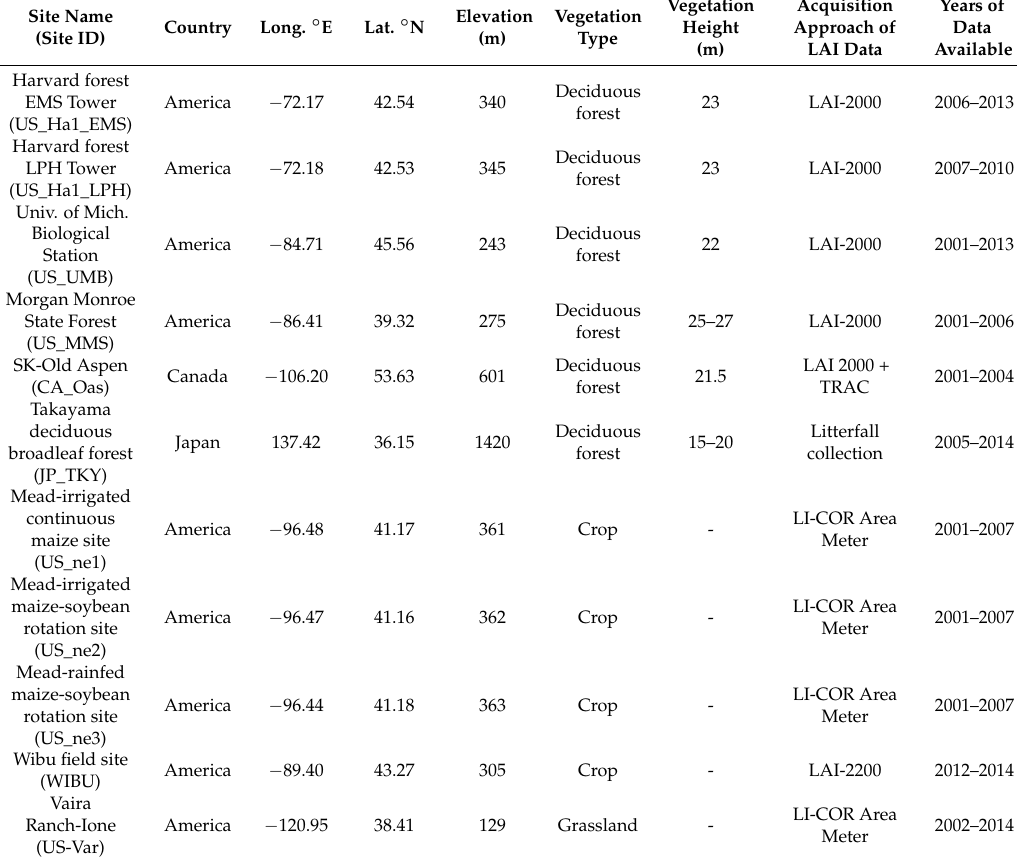
Table 1. Site locations, characteristics, and years of data